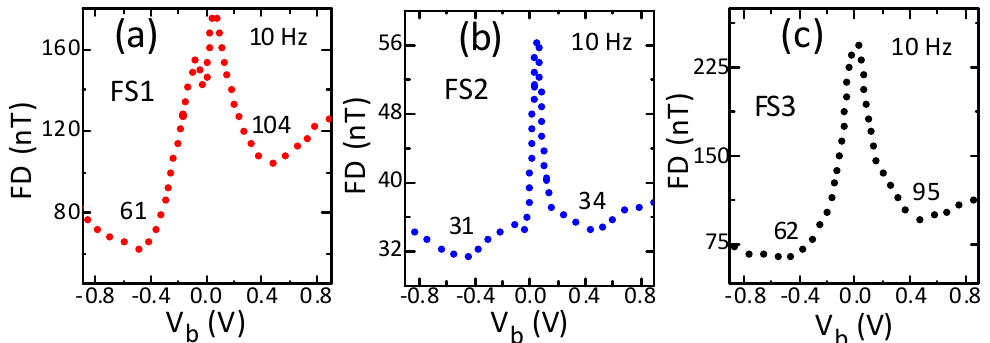
Figure 5. Influence of bias voltage on low-frequency field detection of sensors with high ( a ), medium ( b ) and low ( c ) sensitivity. The field detection was measured at the highest sensitivity point on the transfer curve. The field detection performance showed significant improvement with bias and all sensors showed the best field detection under negative